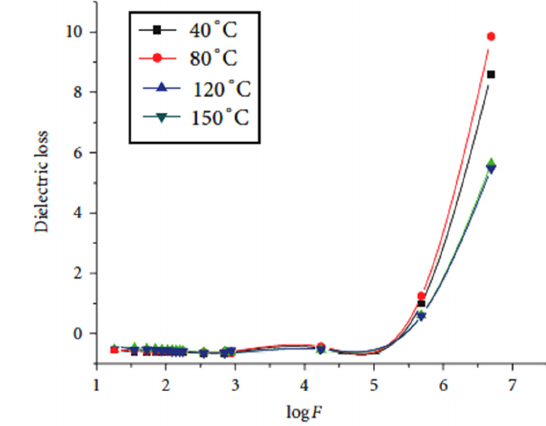
Figure 5. Plot of (αhν) [2] vs photon energy (hν).